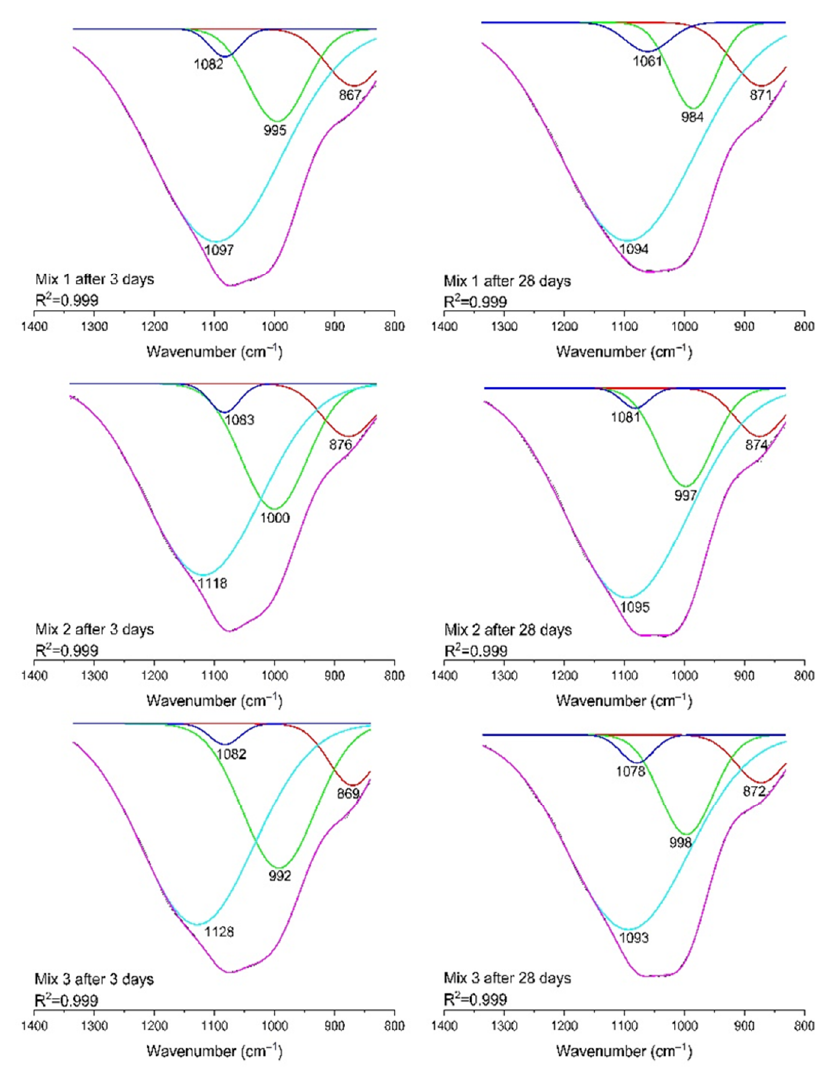
Figure 10. FTIR spectrum deconvolution of geopolymers.